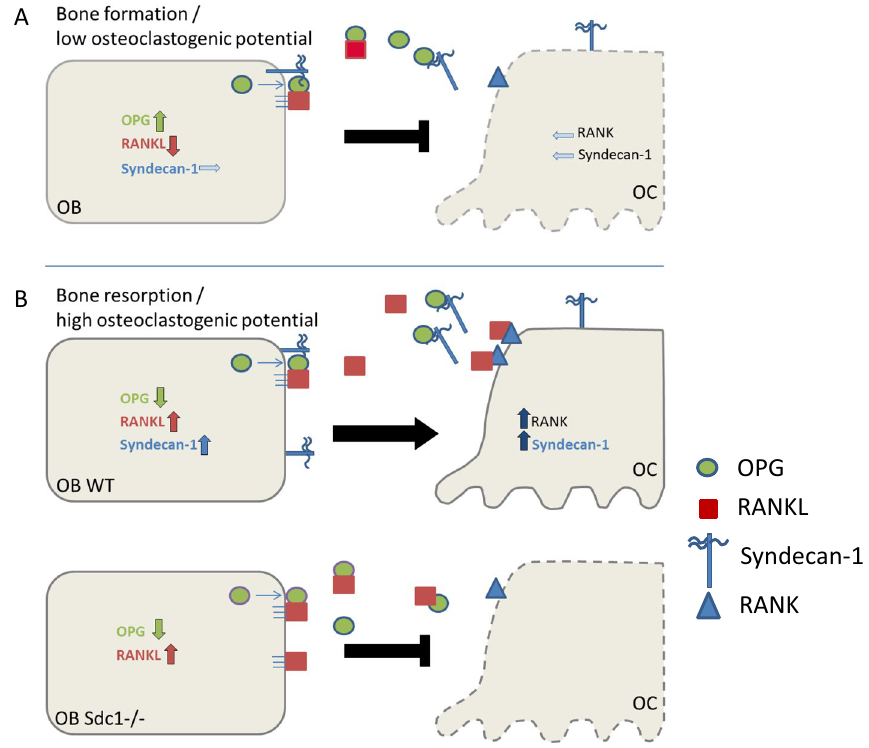
Figure 6. Proposed function of Syndecan-1 in local bone cell communication (model), ( A ) Syndecan-1 has a minor function in bone forming osteoblasts with low osteoclastogenic potential. ( B ) Syndecan-1 produced by osteoblasts with high osteoclastogenic potential supports osteoclast differentiation by OPG